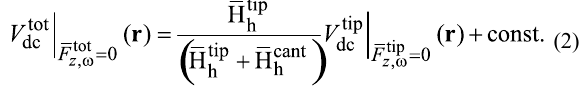
without the cantilever, represented by the dashed and solid lines, respectively. For a probe–sample distance of 1.2